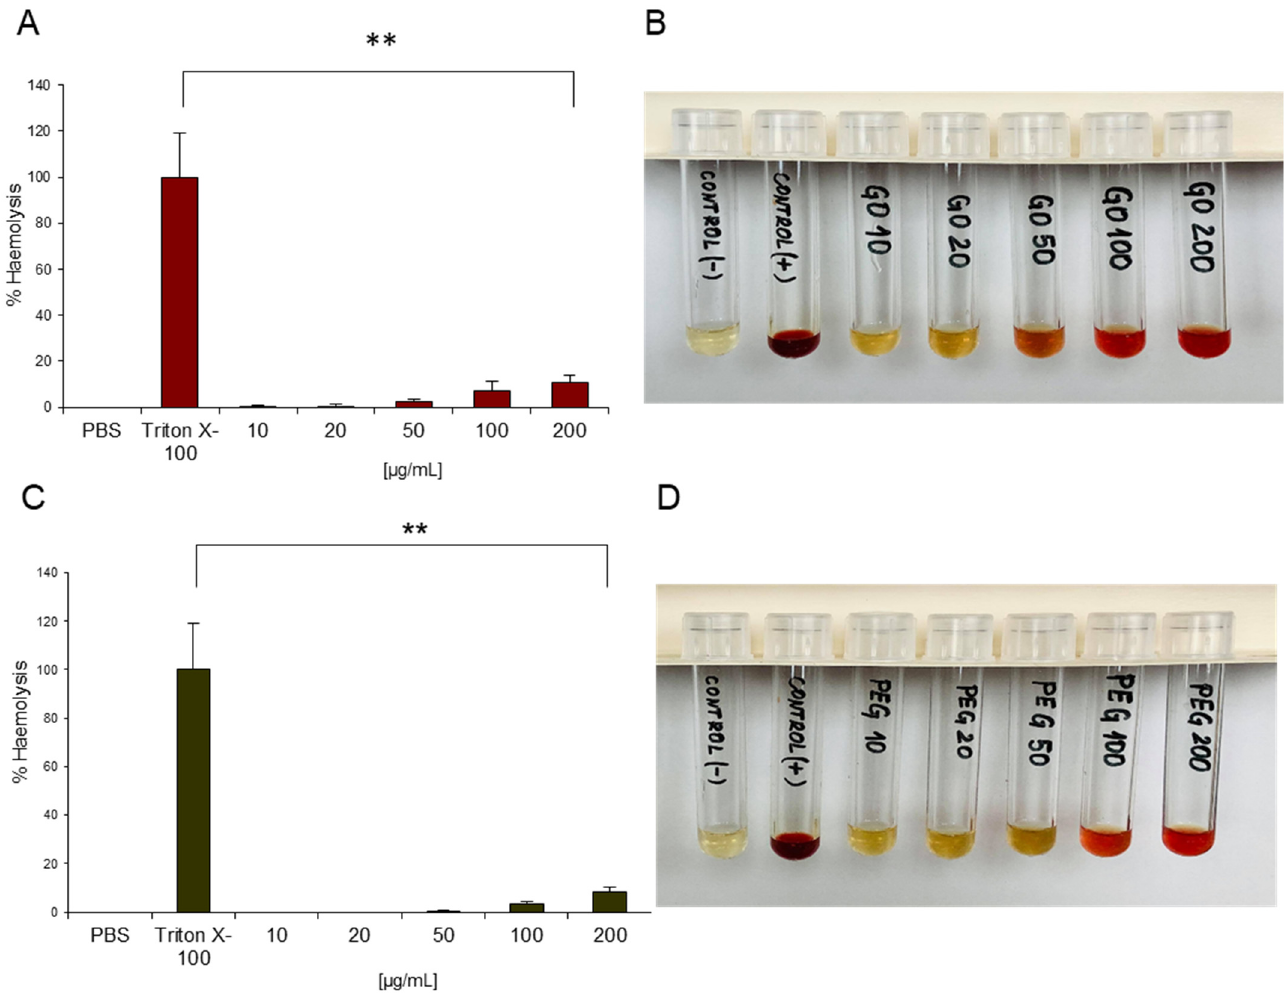
Figure 2. Haemolytic activity of nGO and nGO-PEG NPs. Percentage of haemolysis induced by nGO ( A ) and nGO-PEG ( C ), respectively. Visual inspection via optical images of the tubes containing diluted total blood after exposure to nGO ( B ) or nGO-PEG ( D ) for 3 h after centrifugation. PBS and Triton-X-100 were, respectively, used as negative control and positive control. ** p < 0.01 denotes significantly different results from the negative control.